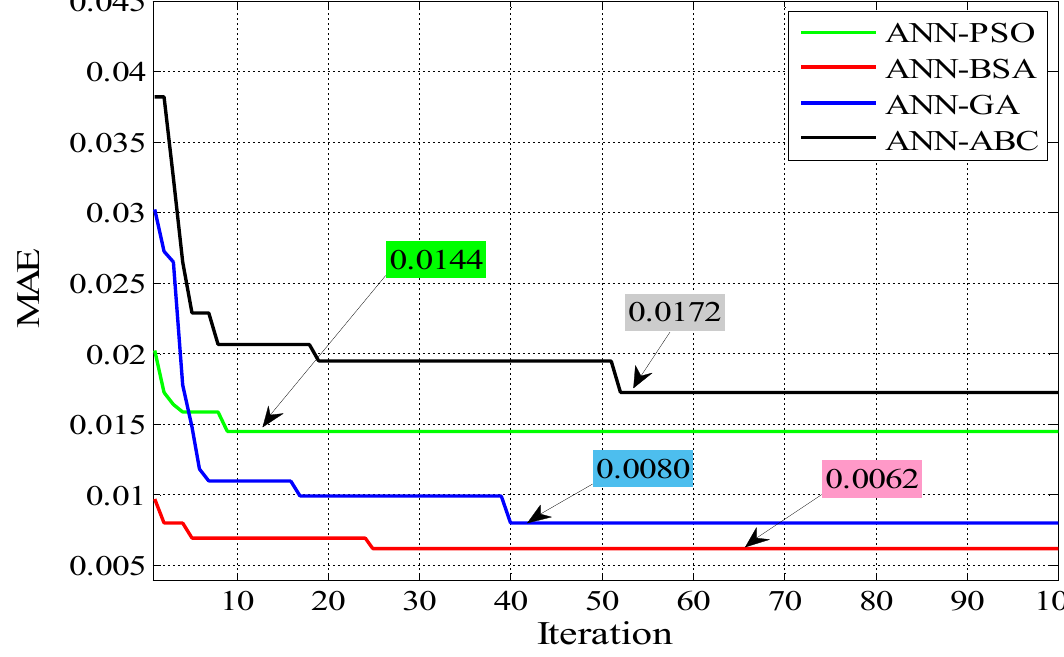
Figure 9. Objectives of optimization algorithms for ANN-PSO, ANN-GA, ANN-ABC, and ANN- BSA for 100 iterations.